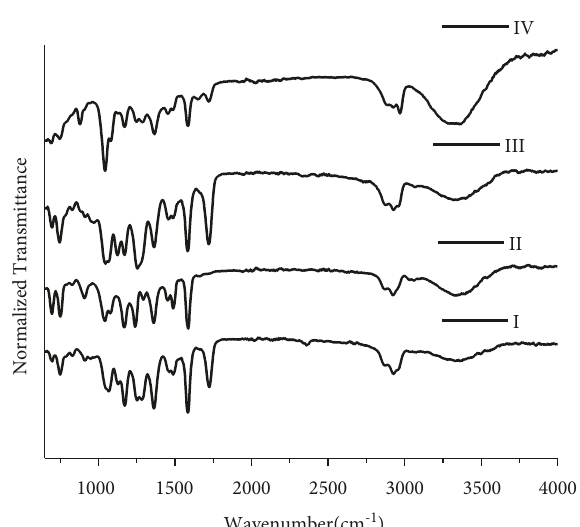
Figure 5: FTIR spectra for groups of I II, III, and IV blue ballpoint pen inks.